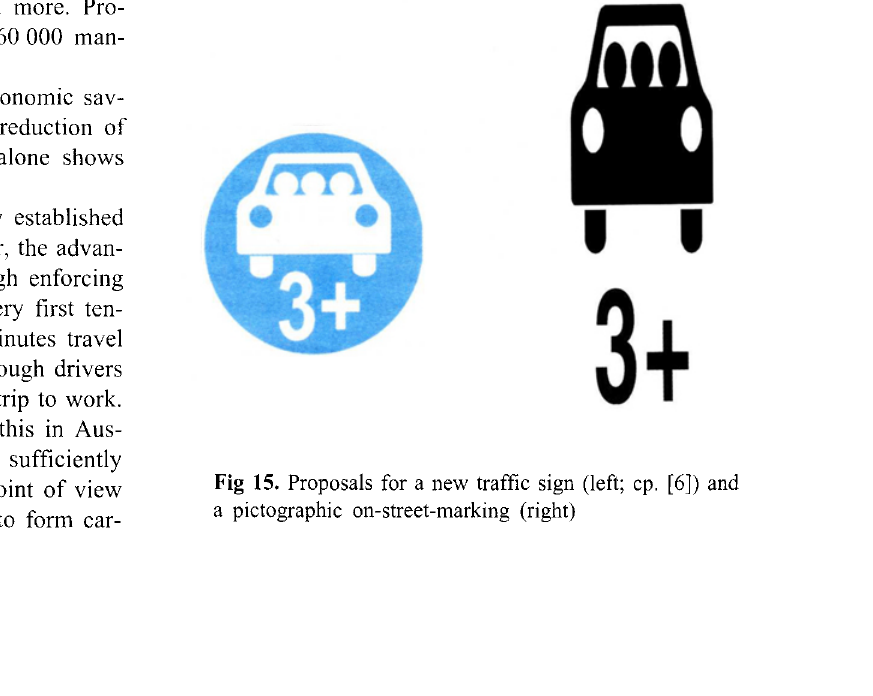
Fig 15. Proposals for a new traffic sign (left; cp. [6]) and a pictographic on-street-marking